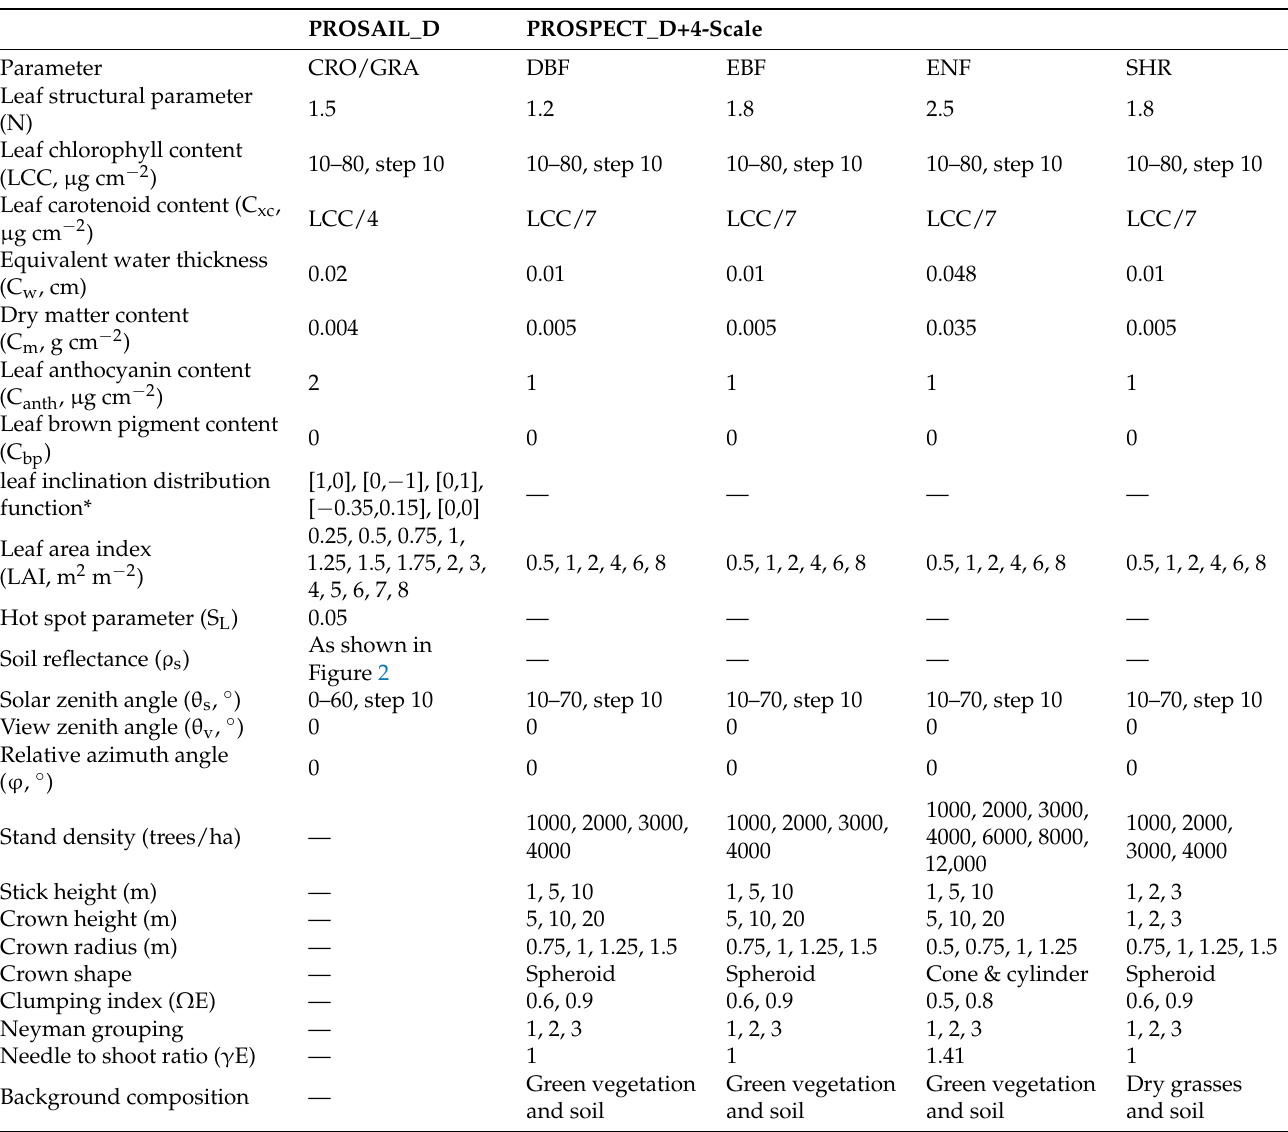
Table 4. Input parameters in the PROSAIL_D and the PROSPECT_D+4-Scale models for LUT